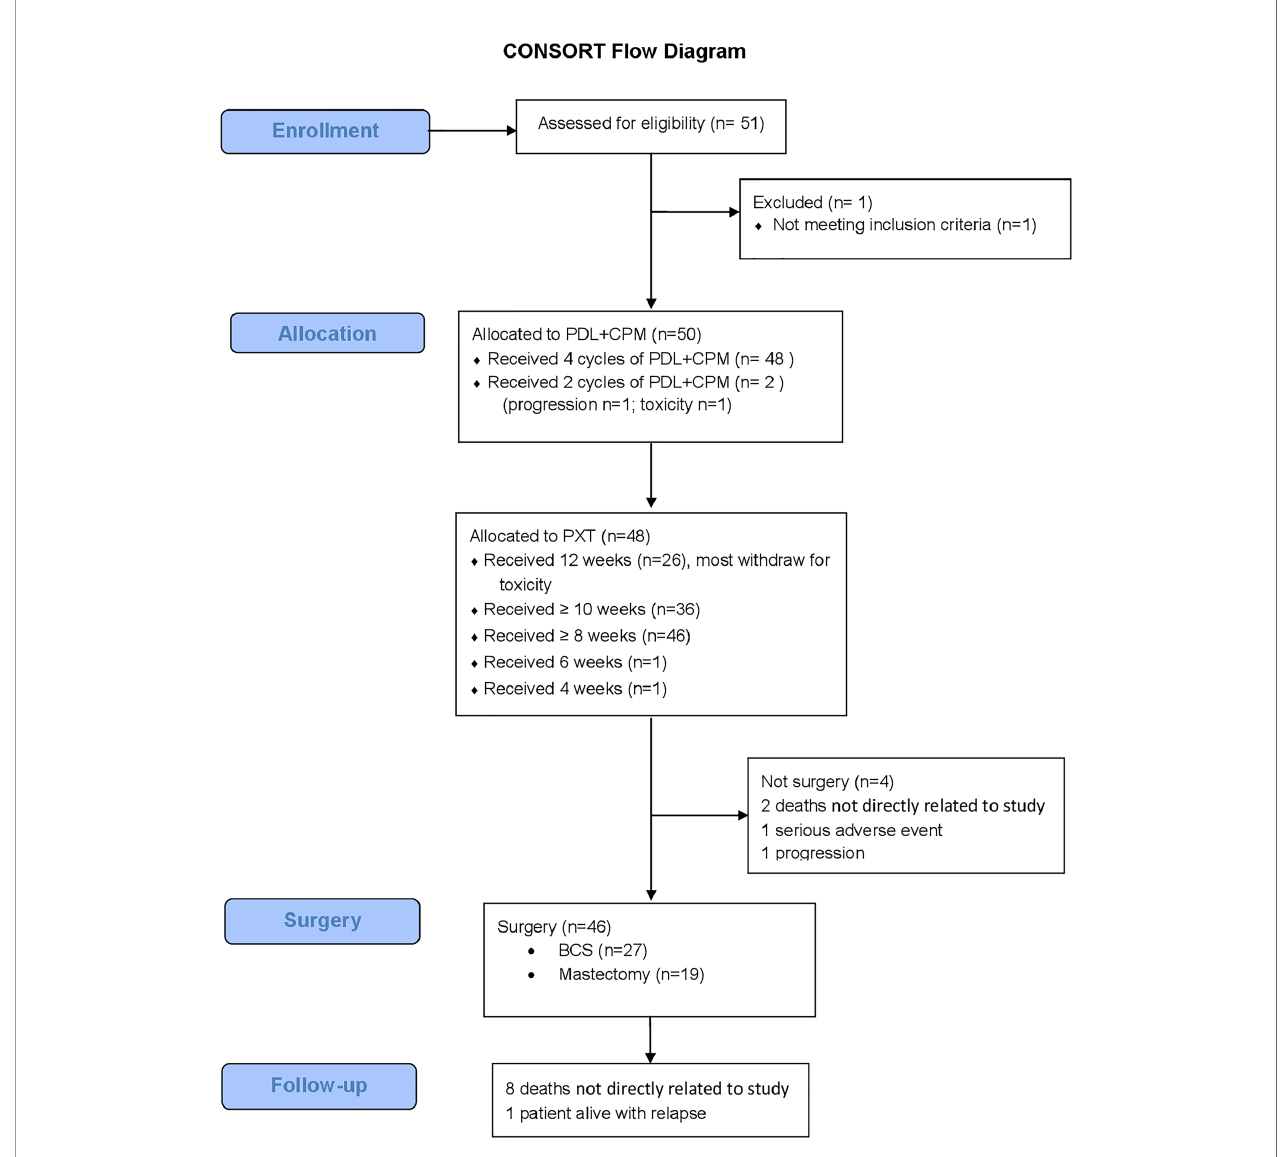
FIGURE 2 | Consort fl ow diagram. n, number; PLD, Pegylated liposomal doxorubicin; CPM, Cyclophosphamide; PTX, Paclitaxel; BCS, Breast Conservation